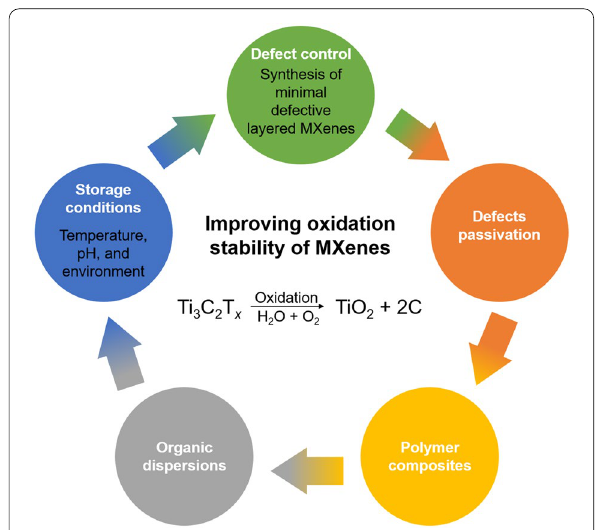
Fig. 14 Control factors for preventing oxidation of